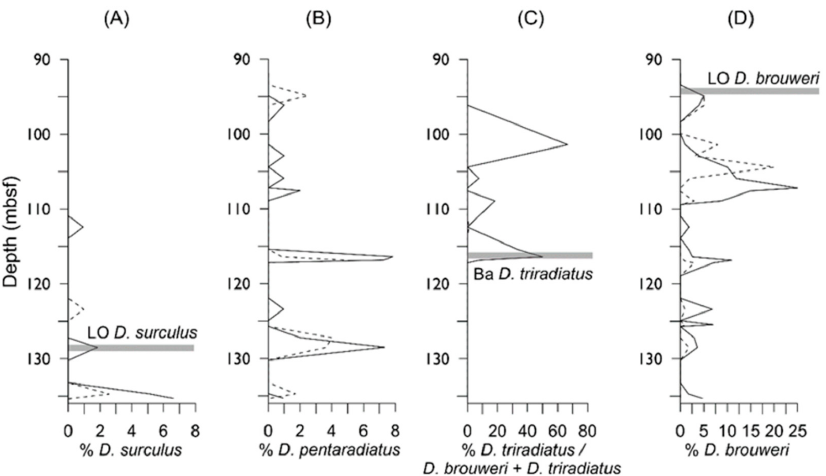
Figure 5. Relative percentages of ( A ) Discoaster surculus , ( B ) D. pentaradiatus , ( C ) D. triradiatus / D. brouweri + D. triradiatus , and ( D ) D. brouweri with depth. Highlighted portions approximate the position of the datum from biostratigraphic data. Solid lines denote complete specimens while broken lines signify incomplete specimens. Abbreviations listed: LO—last occurrence, Ba—base acme.